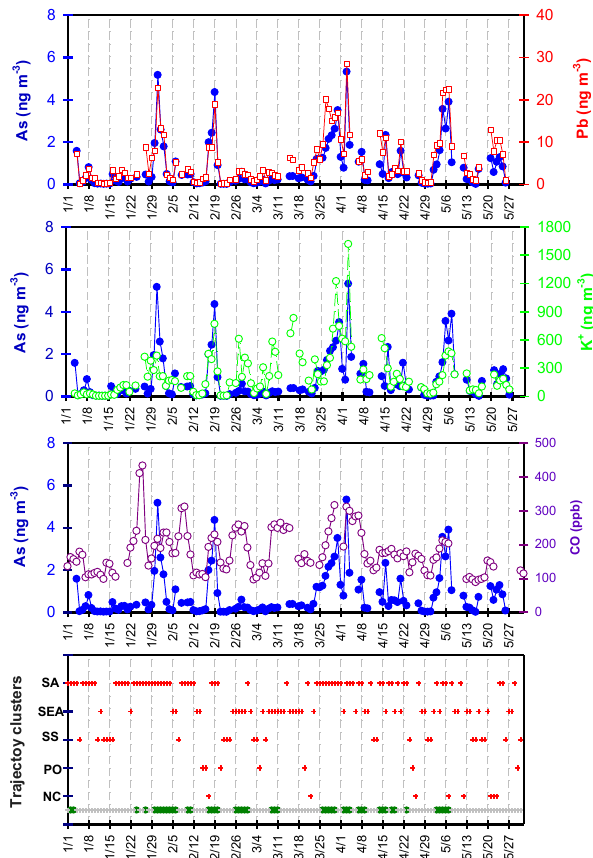
Figure 6. Time series of daily airborne particulate As, Pb, K + , and CO concentrations and clusters of backward trajectories observed from January to May in 2012. In the bottom panel, the green and grey crosses denote the BB and non-BB samples identified in the